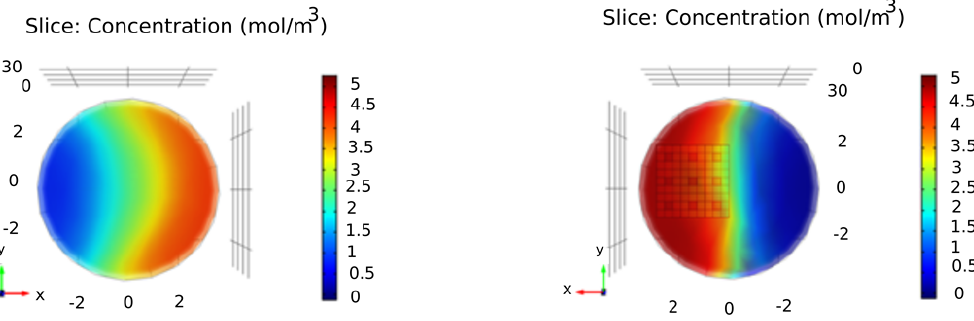
Figure 6. Fluid velocity magnitude distribution for fractals in the zero, first, and second iterations.